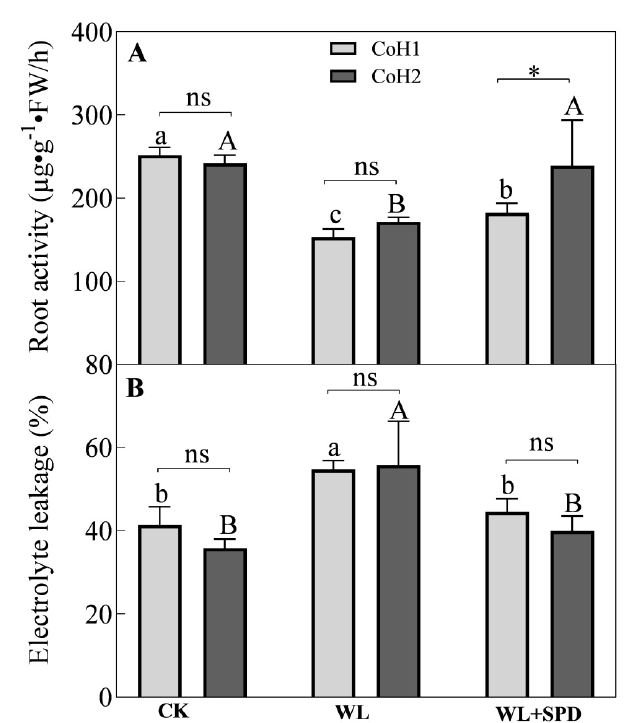
Figure 1. Variations in Root activity ( A ) and EL ( B ) in C. oleifera seedlings under WL exposed to SPD. The bars on the top show SE (n = 5), and different lowercases and uppercases indicate significant differences among CK, WL, and WL + SPD treatments within each species according to Tukey’s multiple comparison test, respectively ( p < 0.05). The signs such as * and ns in the figures concern the significance difference between the same treatment for CoH1 and CoH2 (*, p < 0.05; ns , Not significant). CK: control; WL: waterlogging; SPD: spermidine.